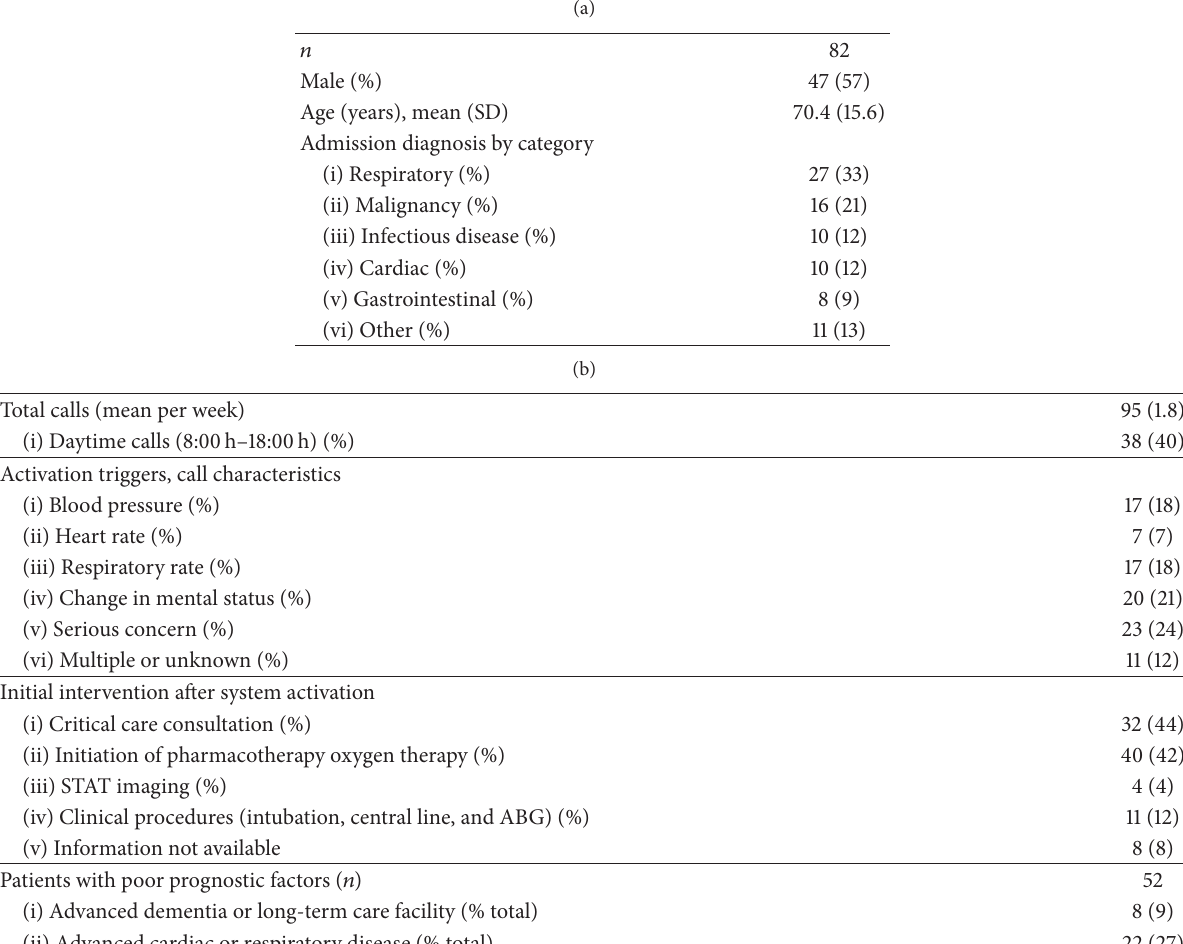
Table 1: Baseline characteristics, call records, and